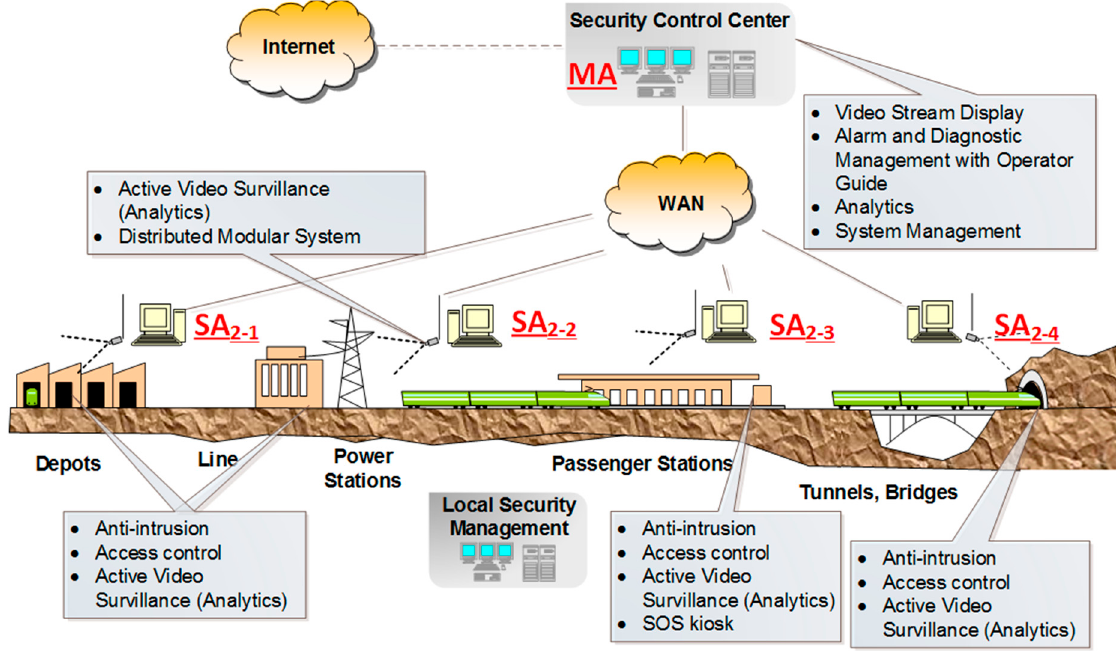
Figure 6. The outdoor WSN for the on-route scenario. The MA is deployed in the security control center and the four SAs